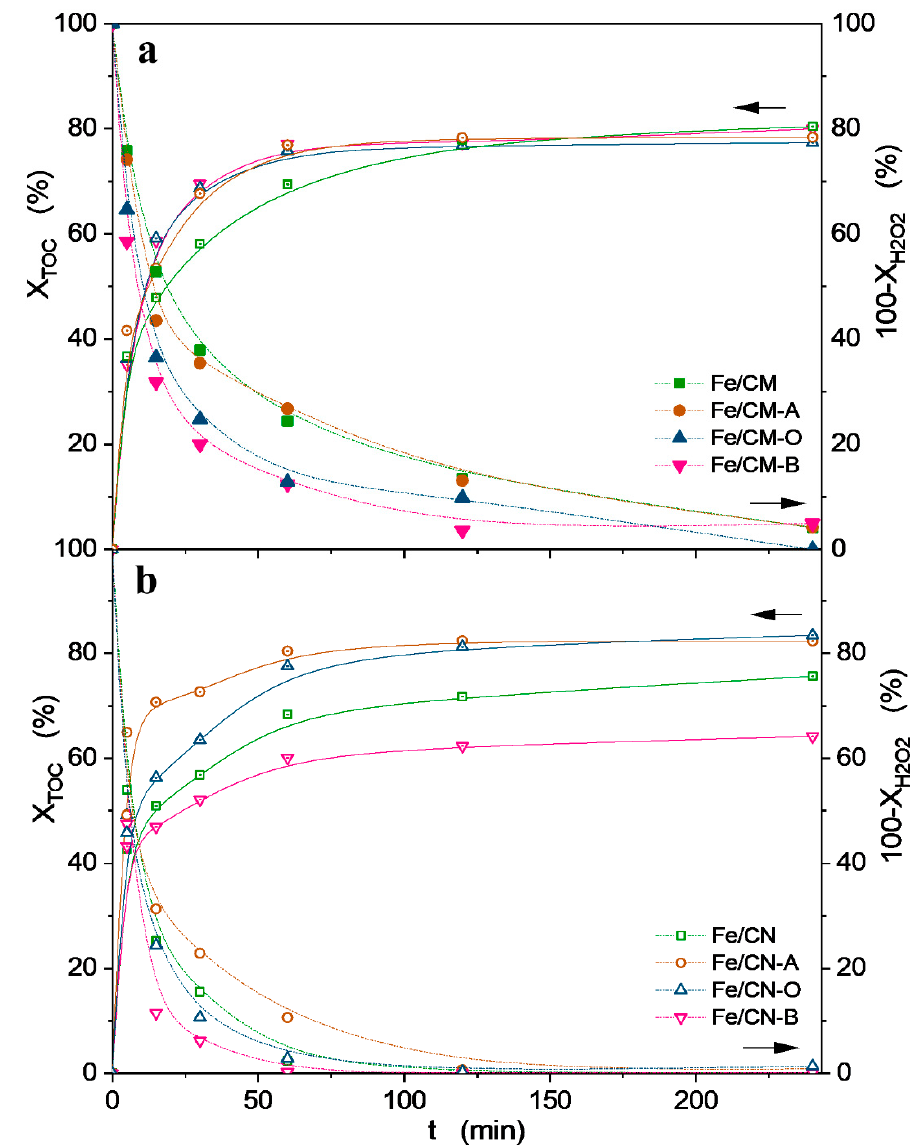
Figure 4. Evolution of TOC and consumed H 2 O 2 along reaction time: ( a ) Fe/CM- f catalysts and ( b ) Fe/CN- f catalysts. Reaction conditions: 50 mL reaction volume, 100 mg · L − 1 phenol, 500 mg · L − 1 catalyst, 500 mg · L − 1 H 2 O 2 , pH 3, 200 rpm, 50 °C.